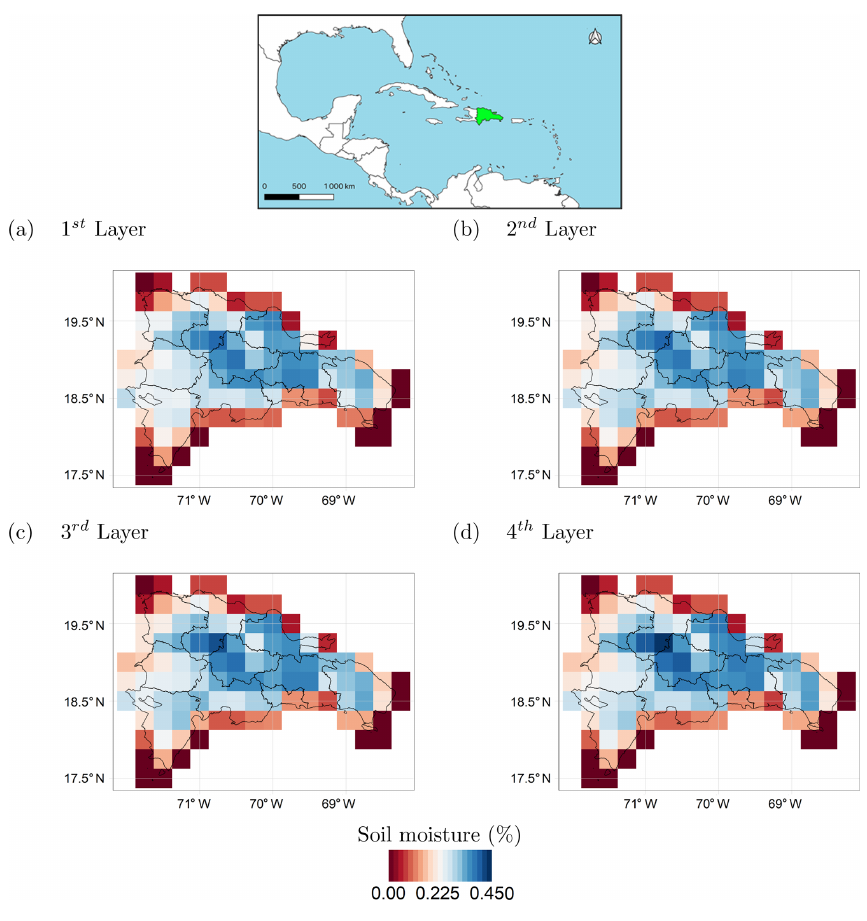
Figure 6. Average soil moisture over the Dominican Republic in the four soil moisture layers. (a) First layer, 0–7cm; (b) second layer, 7–28cm; (c) third layer, 28–100cm; (d) fourth layer, 100–289cm.